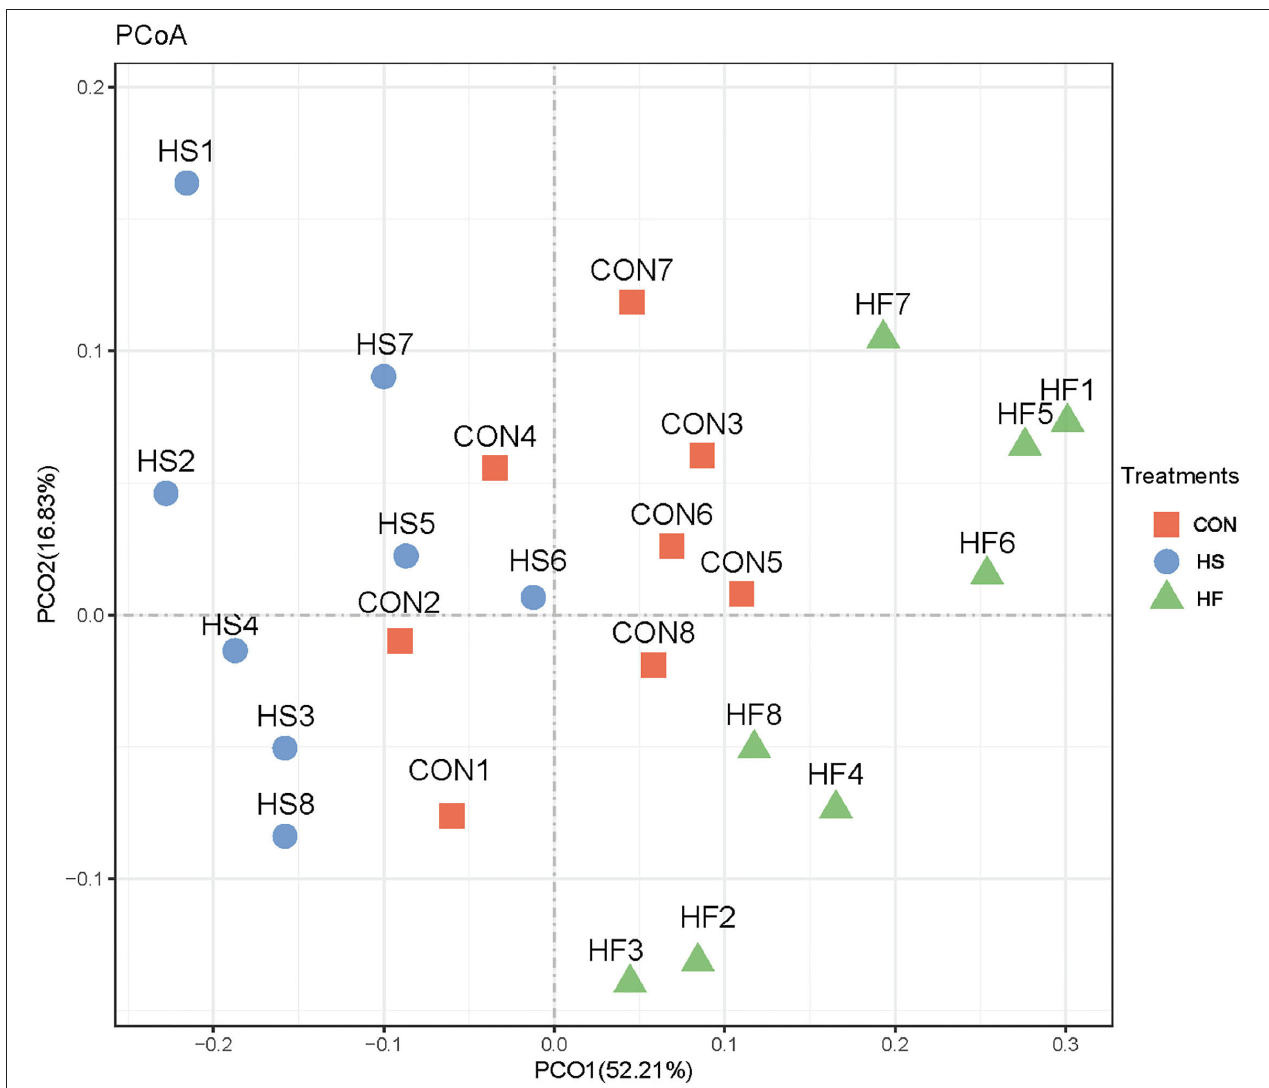
FIGURE 2 | Principal coordinate analysis (PCoA) on ruminal bacterial community structures of CON, HS, and HF treatments. CON, control treatment; HS, heat stress treatment; HF, honeycomb flavonoids supplement treatment.